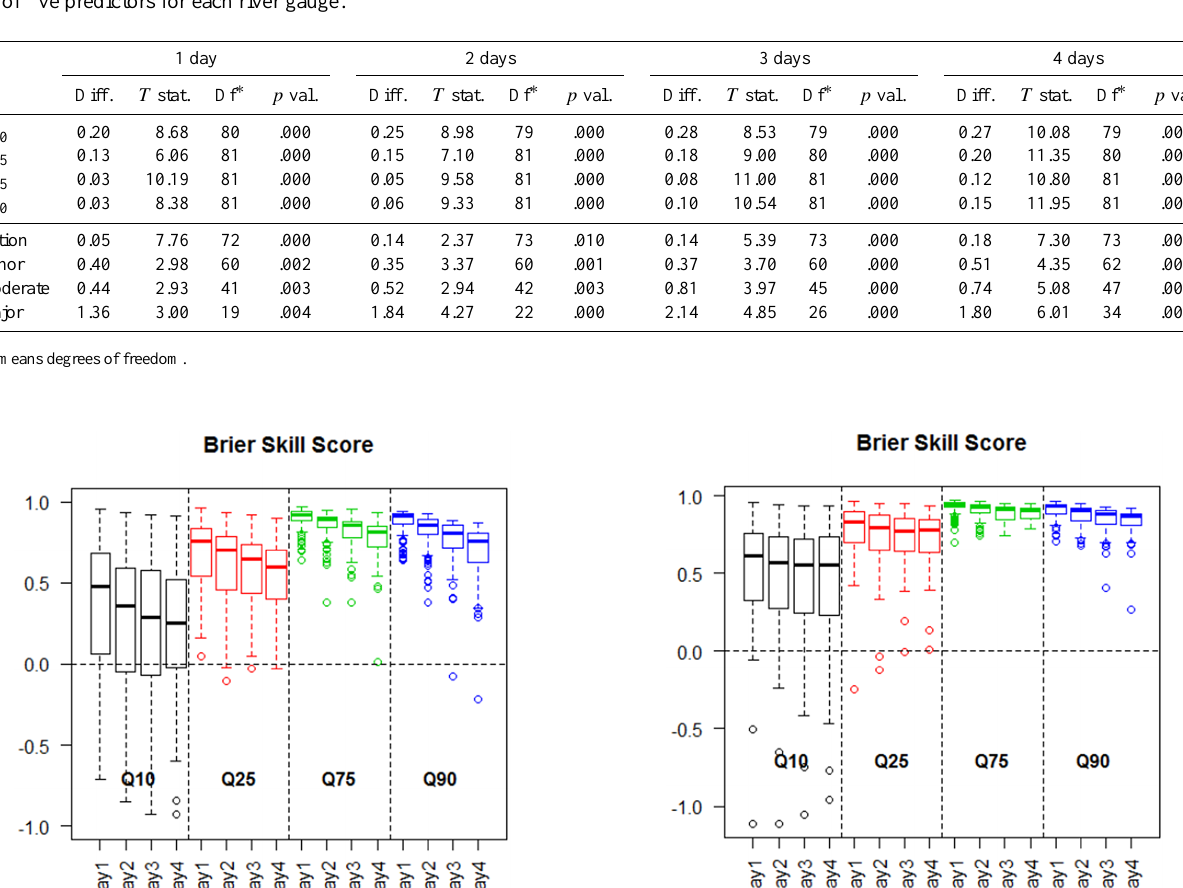
Table 3. Results of paired t tests comparing the QR method’s performance with only forecast as predictor and the best-performing combina- tion of five predictors for each river gauge.